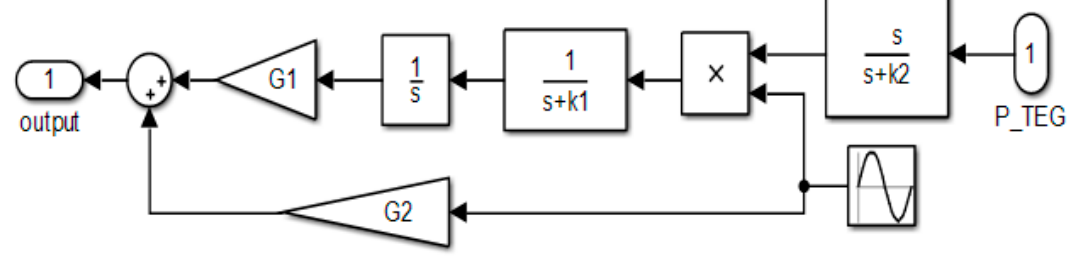
Figure 4. The block diagram of the applied ESC circuit.